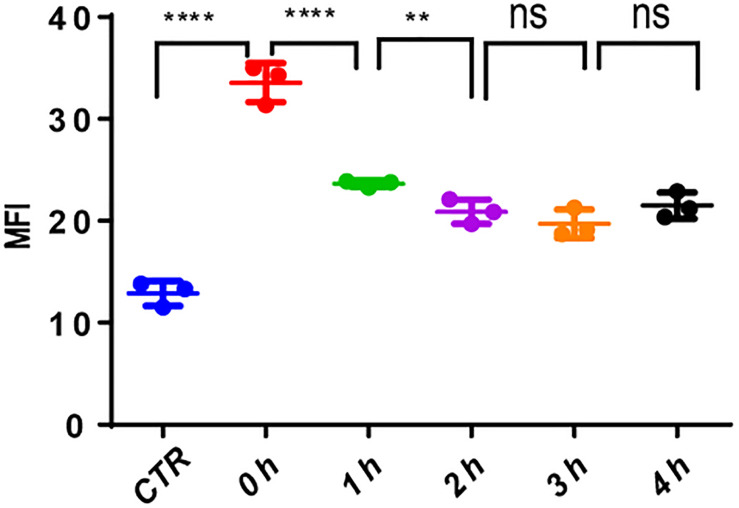
MV4-11 cells repaired DNA damages. MV4-11 cells were pretreated with VP-16 for 2 h to induce DSB and then washed off. Cells were then incubated in fresh culture medium for 0, 1, 2, 3, and 4 h. The MFI of γ-H2AX was detected by flow cytometry to evaluate the level of DSBs at each stage. MV4-11 cells not pretreated with VP-16 were used as control. **p < 0.01 and ****p < 0.0001.